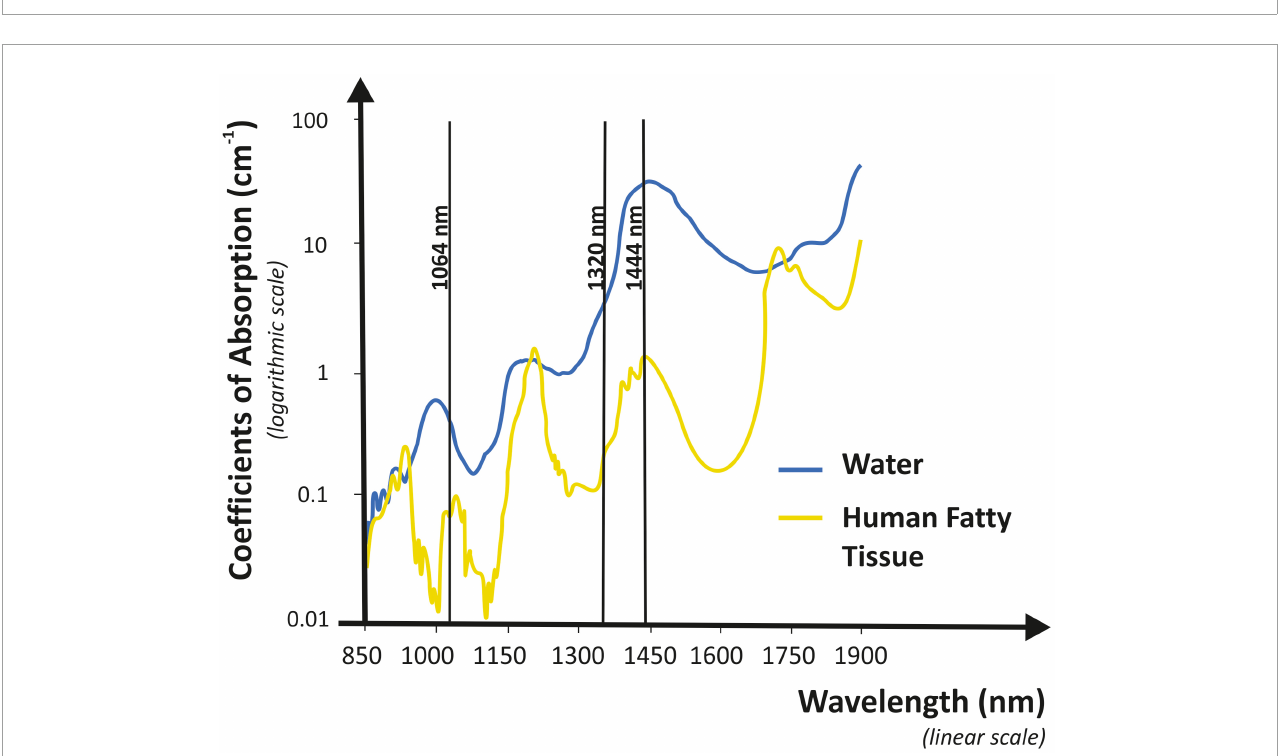
FIGURE3 Graphical representation of absorption coefficient vs. wavelength for water and human fat. The 1,444-nm wavelength shows high selectivity characteristics and it is highly absorbed by human fat.